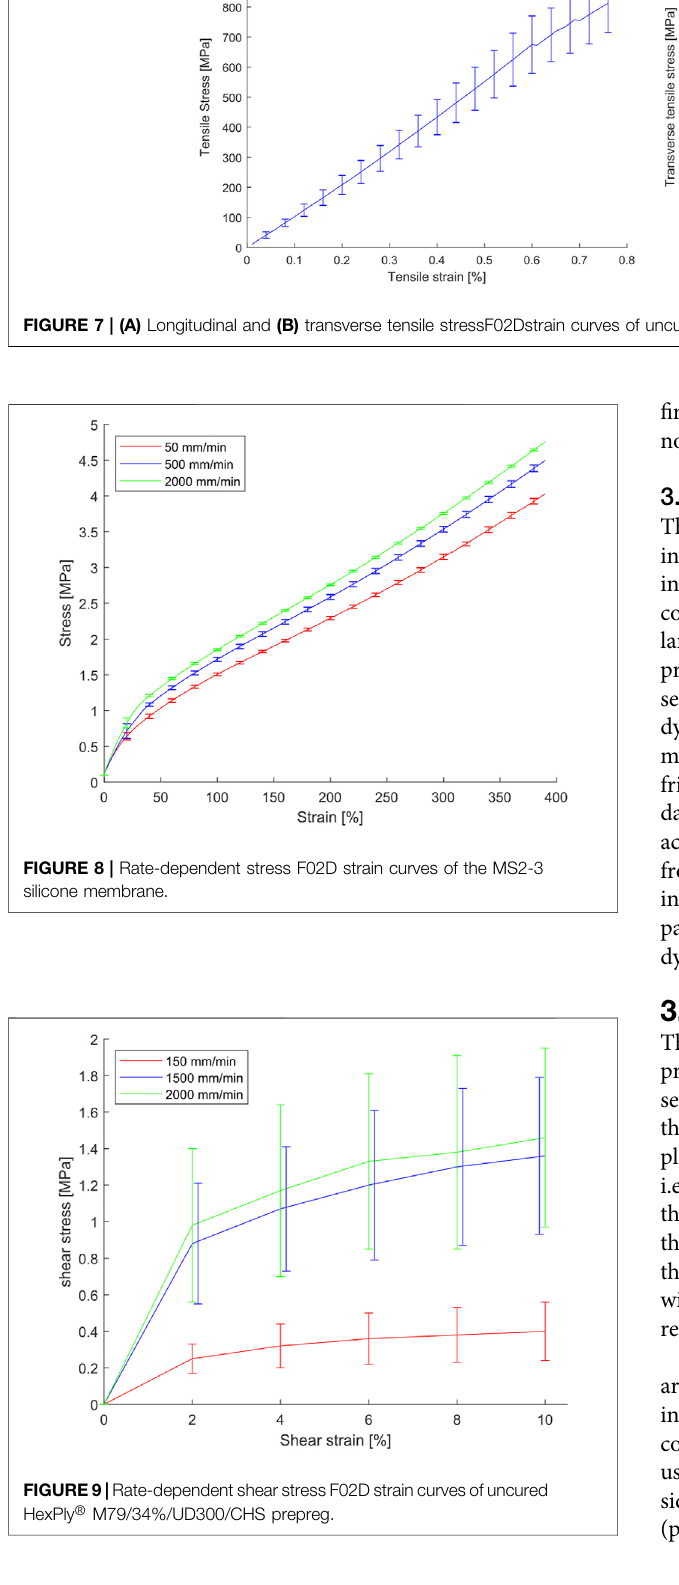
Frontiers in Materials |